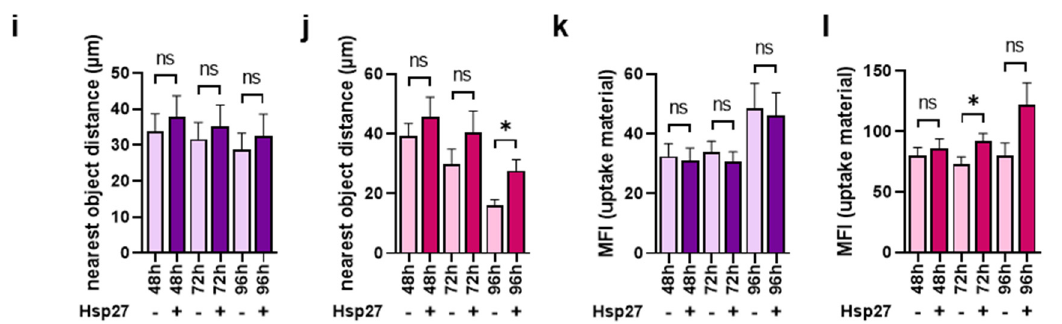
Figure 5. High-content imaging of HL-60 cells co-cultured with prostate cancer cells under Hsp27 treatment. ( a ) representative overlay images of untreated (control) and Hsp27-treated co-cultures (cc) of CellTrace Violet-labeled prostate cancer cells (blue) and CellTrace Far Red-labeled HL-60 cells (red), with SYTOX Green (green) as dead cell marker at 96 h; ( b ) PCAs of several morphology properties quantified by algorithm-based image analysis of HL-60 cells; ( c – l ) algorithm-based image quantification of HL-60 total cell count ( c , d ), the total aggregate area in µ m 2 ( e , f ), number of cells interacting with the prostate cancer cells ( g , h ), distance to the nearest prostate cancer cell in µ m ( i , j ), and mean fluorescence intensity (MFI) of dead prostate cancer cell material internalized by HL-60 cells ( k , l ). Data are presented as mean + SE. Statistical analysis was performed using unpaired, two-tailed t -test with p < 0.05 (*), p < 0.01 (**), and p < 0.001 (***). ns = not significant. Scale bar is 100 µ